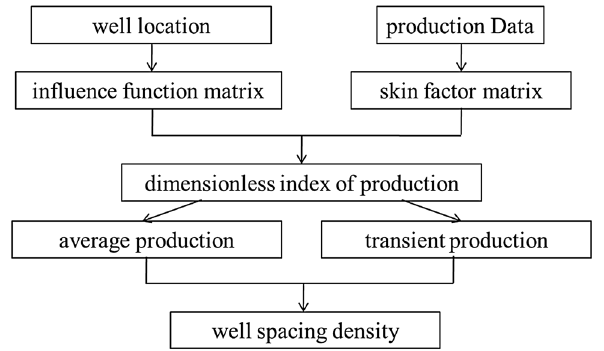
Fig. 2 The calculation diagram of the well spacing density